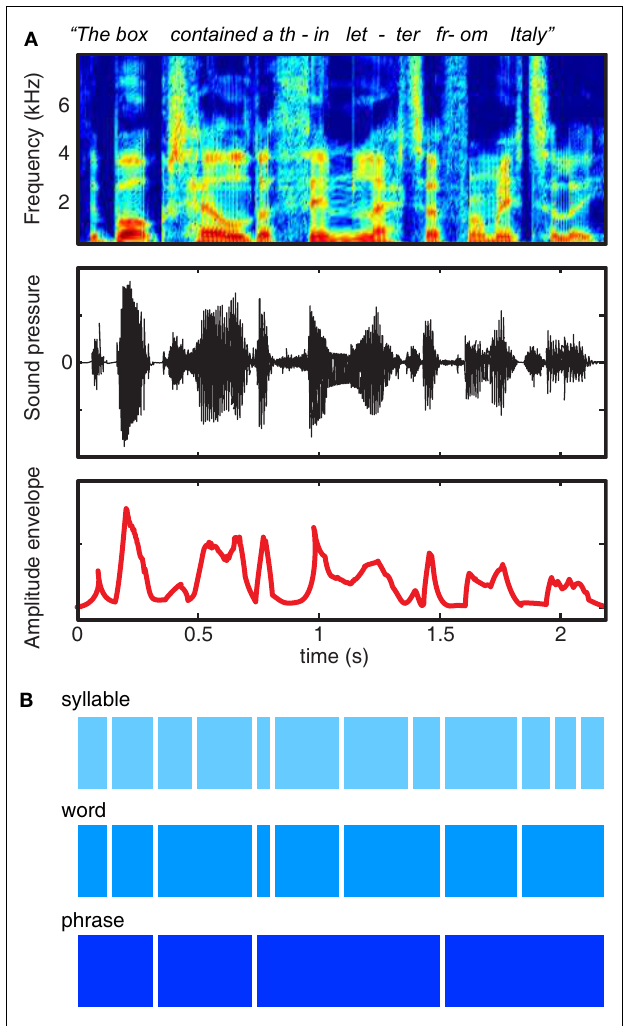
FIGURE 1 | Multiple representations of the acoustic and linguistic information in a single spoken sentence. (A) At top is a spectrogram, showing power in different frequency ranges over the course of a sentence.The middle row shows the changes in sound pressure over time, as occur at the tympanic membrane.The bottom row shows the amplitude envelope of the sentence, corresponding approximately to the syllable rate, and created by half-wave rectifying and low-pass filtering the speech signal. (B) Schematic illustration of three different timescales of acoustic and linguistic information contained in the